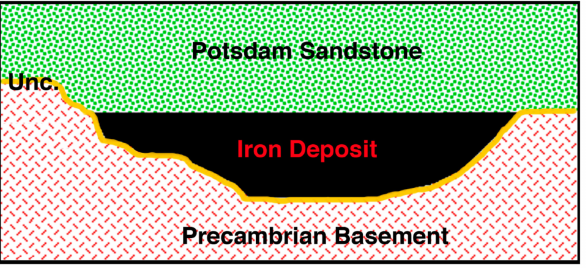
Figure 2. Schematic geology of specular hematite occurrences in St. Lawrence County, NY. The ore sits directly on the Precambrian crystalline rocks at the unconformity (Unc.). Originally, the ore was overlain by the Potsdam Sandstone.